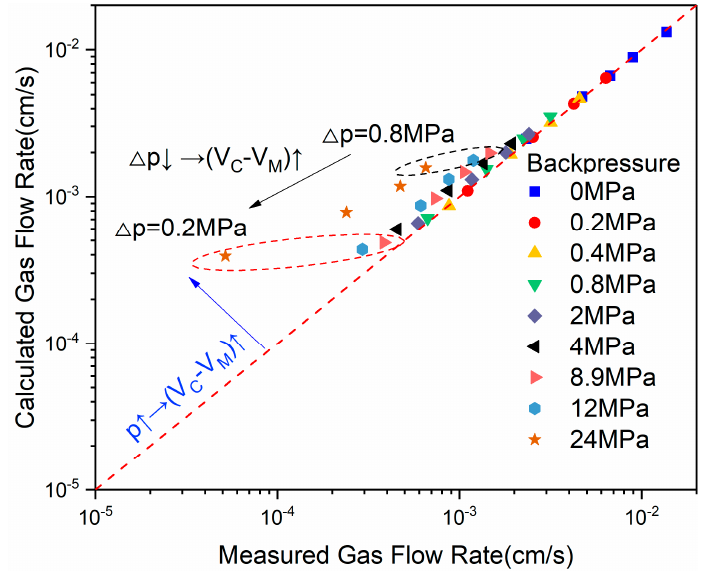
Figure 10. Measured flowrate versus theoretical flowrate at diverse backpressures for core Z3. Energies 2019 , 12 , x FOR PEER REVIEW 14 of 17